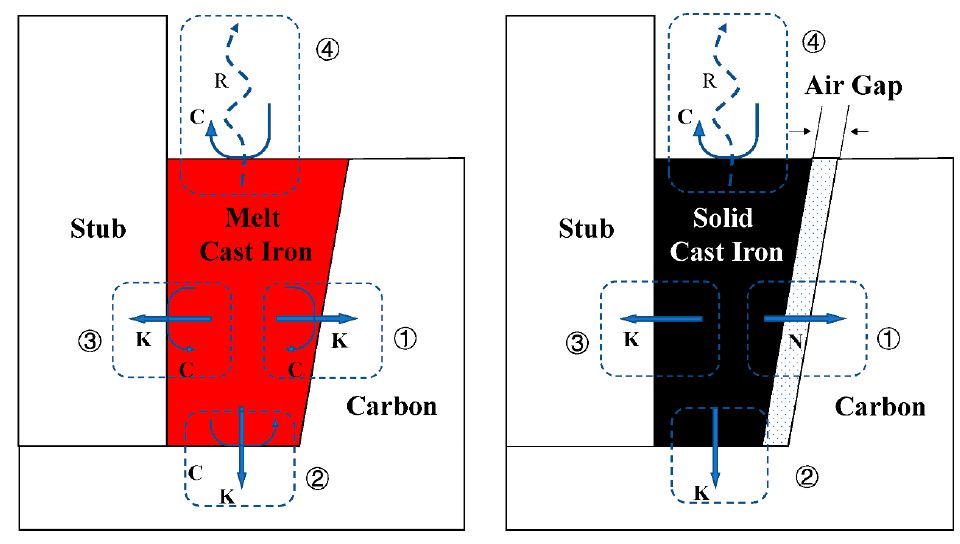
Figure 6. Boundary conditions around cast iron.